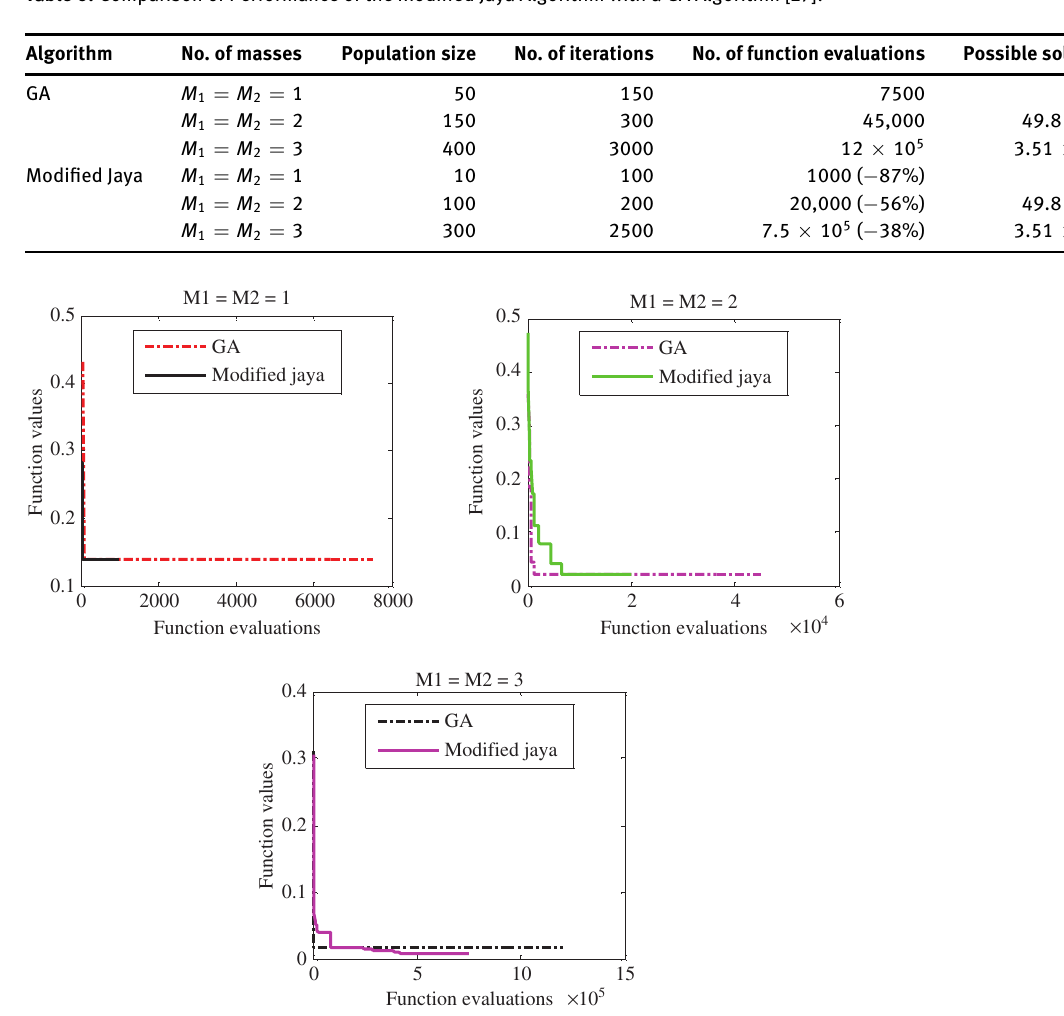
Figure 13: Convergence Rate of Best Objective Function Values in GA and Modified Jaya for the Number of Balance Masses for Case